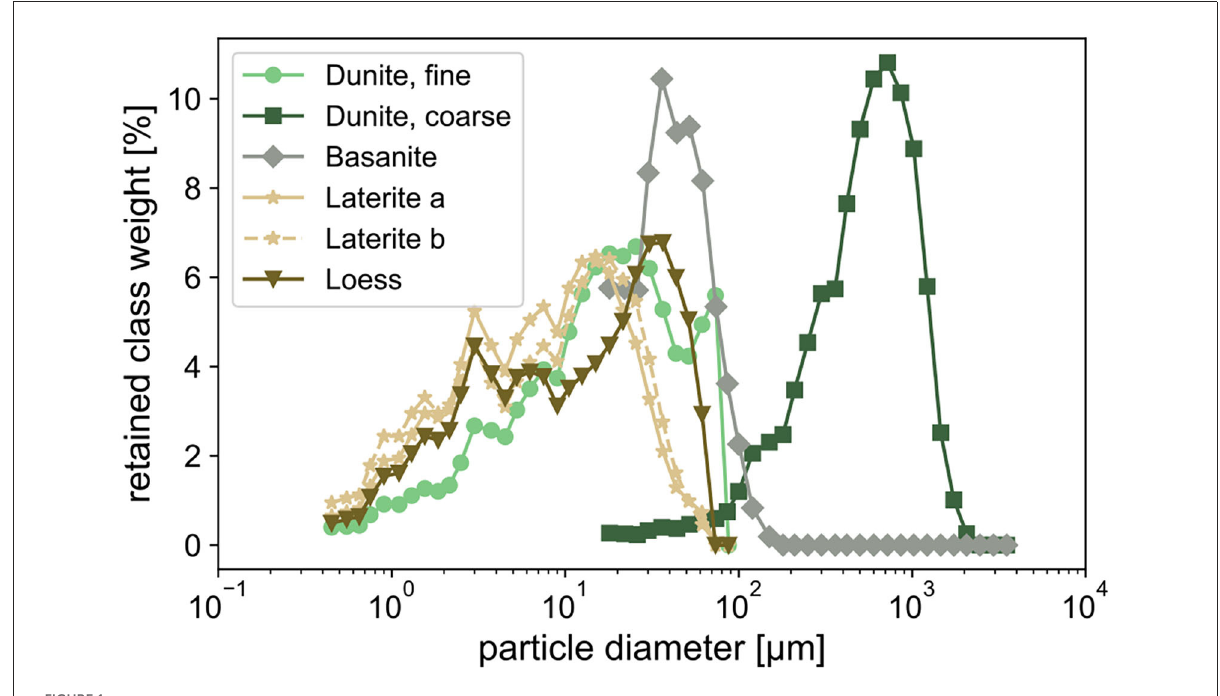
FIGURE1 Grain size distribution of the applied